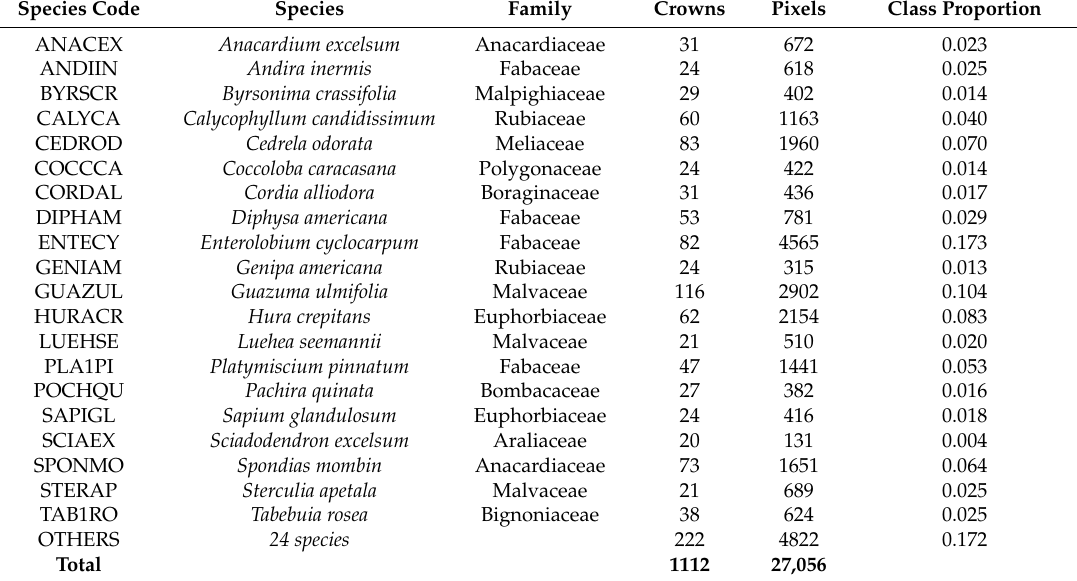
Table 2. Summary of field data. Twenty-one classes were used to train the SVM model. The class proportions were calculated as the number of pixels for the class divided by the total number of